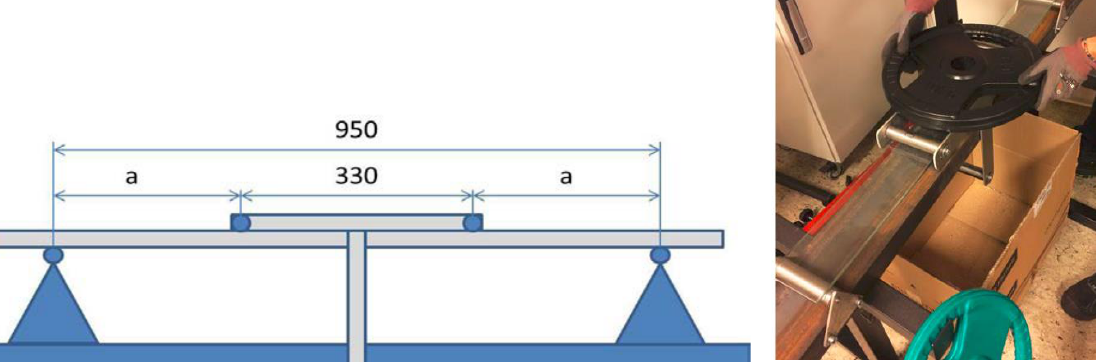
Fig. 3 Schematic drawing and photo of the test setup with the constant load.